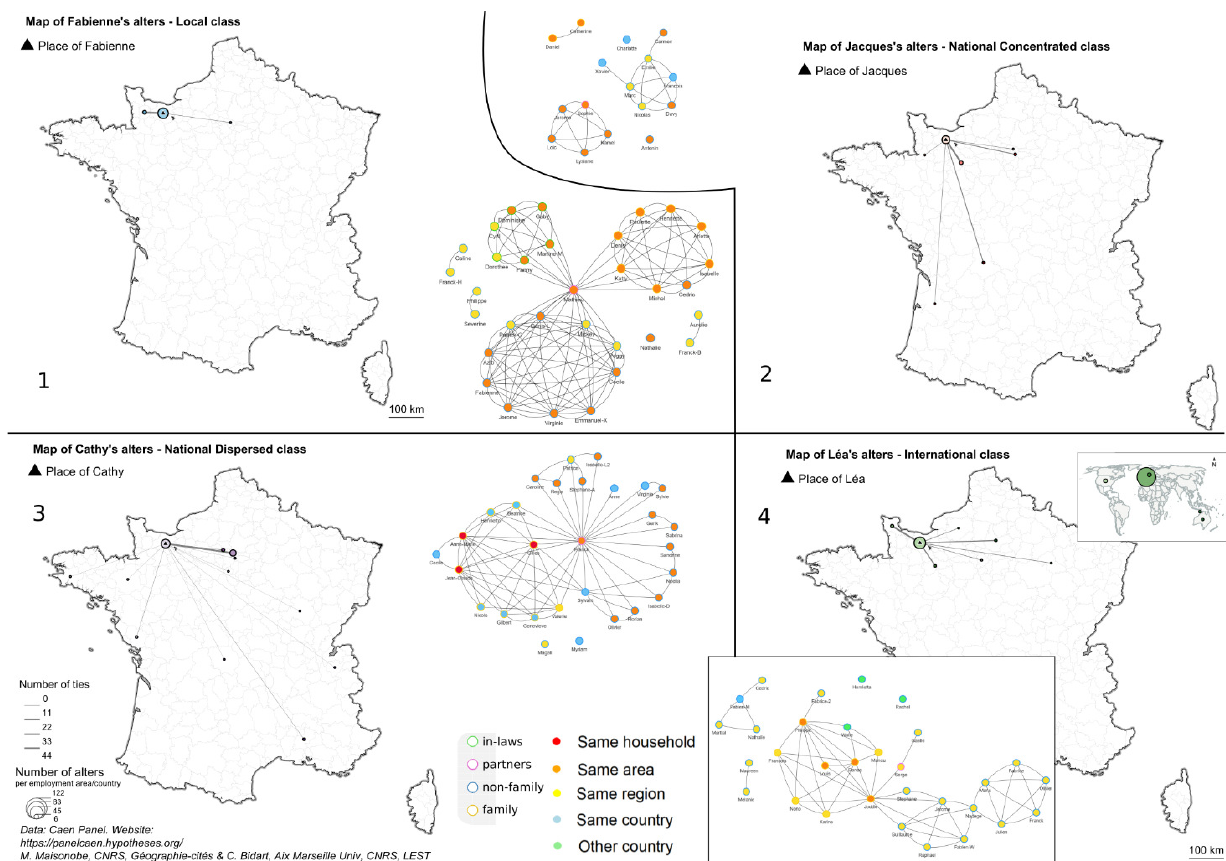
Figure 4. Network diagrams and geographical mappings of the paragons of the Caen Panel